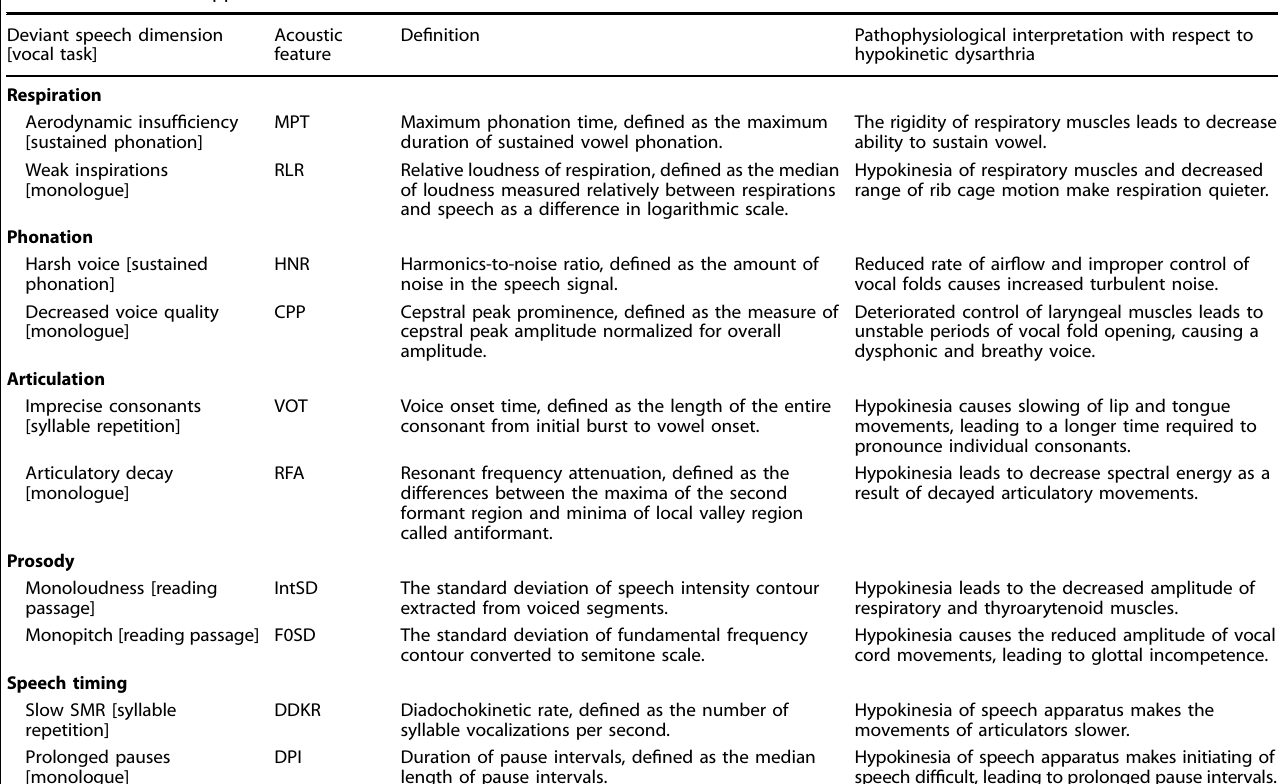
Table 2. Overview of applied acoustic